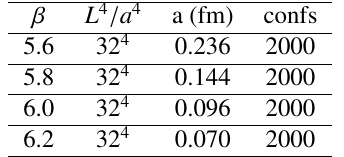
Table 1. Quenched configurations employed for lattice calculations.